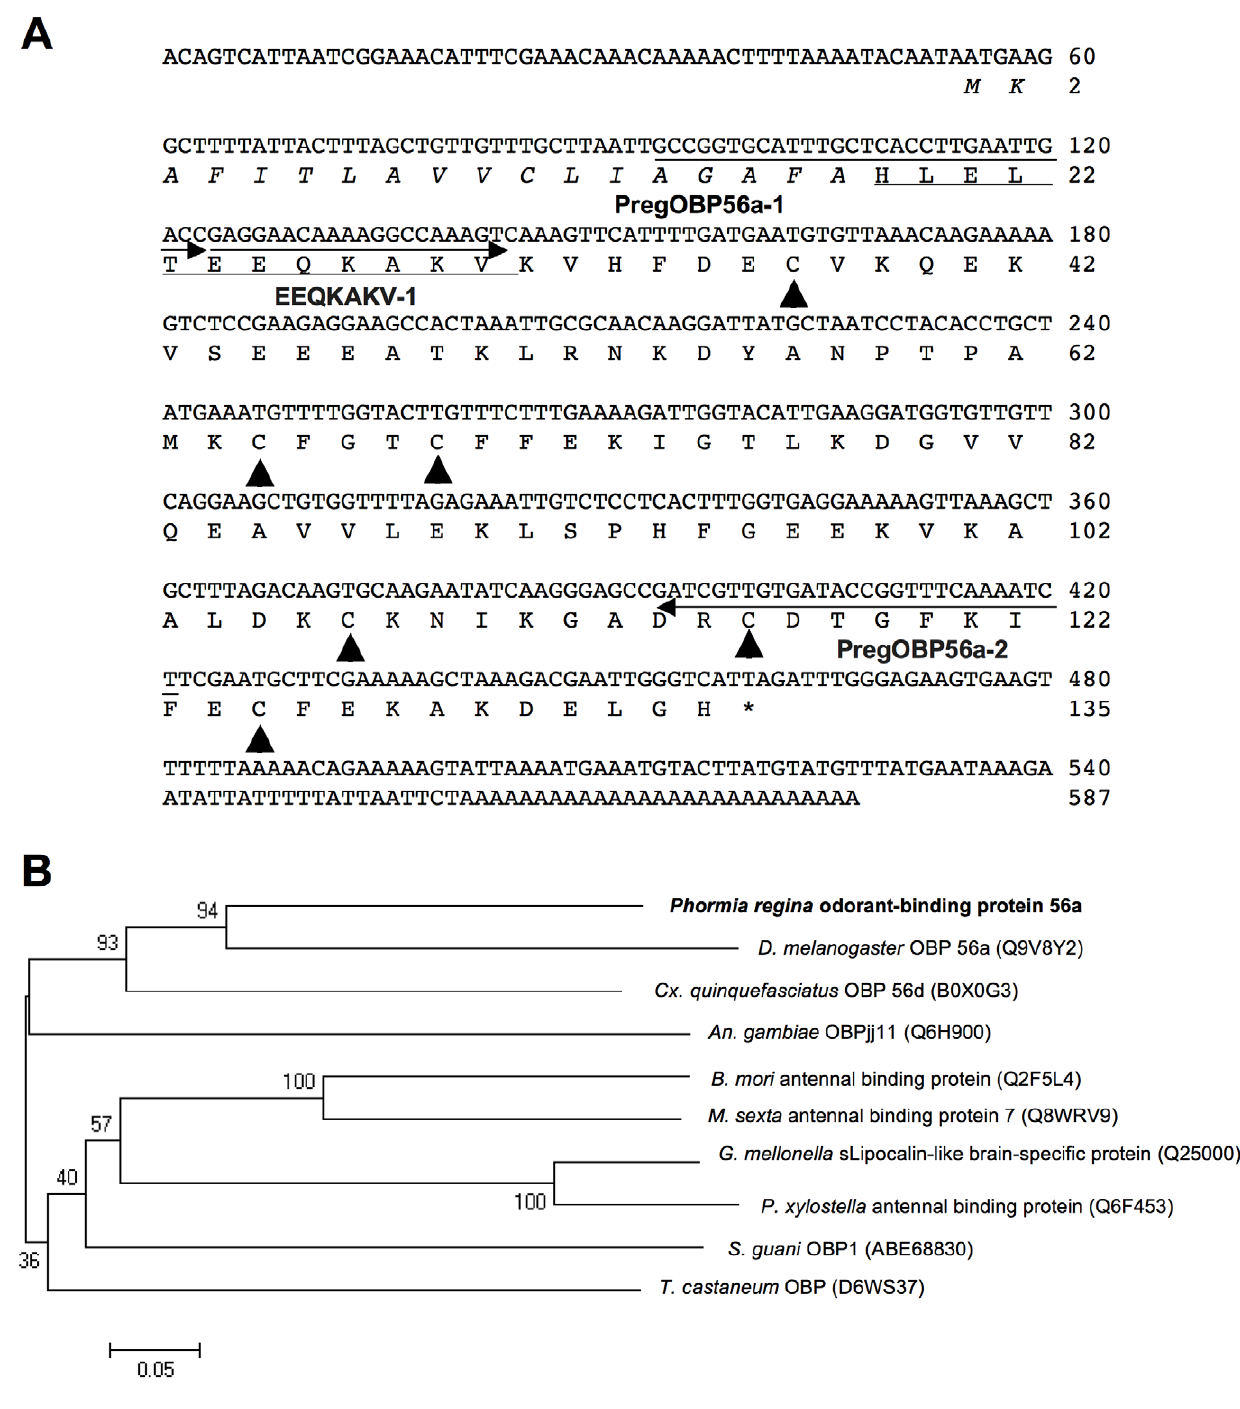
Figure 2. Nucleotide and deduced amino acid sequences and phylogenetic analysis of oral disk-specific protein (PregOBP56a). A, cDNA and deduced amino acid sequences of an oral disk-specific protein. A signal peptide is shown in italic. N-terminal amino acid sequence determined by Edman degradation is underlined. Arrowheads show 6 cysteine residues, which are hallmarks of insect classic OBPs. The three arrows indicate annealing sites of a degenerate (EEQKAKV-1) and two gene-specific (PregOBP56a-1 and PregOBP56a-2) primers, B, Phylogenetic tree of odorant-binding protein 56a like-protein sequences. Phormia regina odorant-binding protein 56a is shown in bold. Accession numbers of each protein are given in the parenthesis. Bootstrap values were determined from 1,000 replications. Bar indicates 5% divergence.